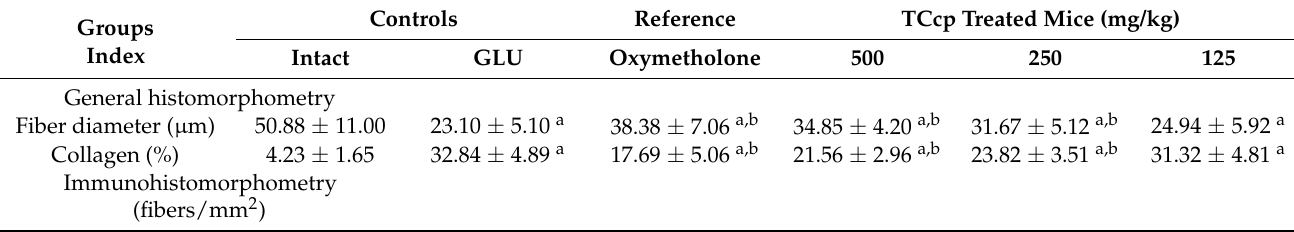
Table 6. Changes in the gastrocnemius muscle histomorphological